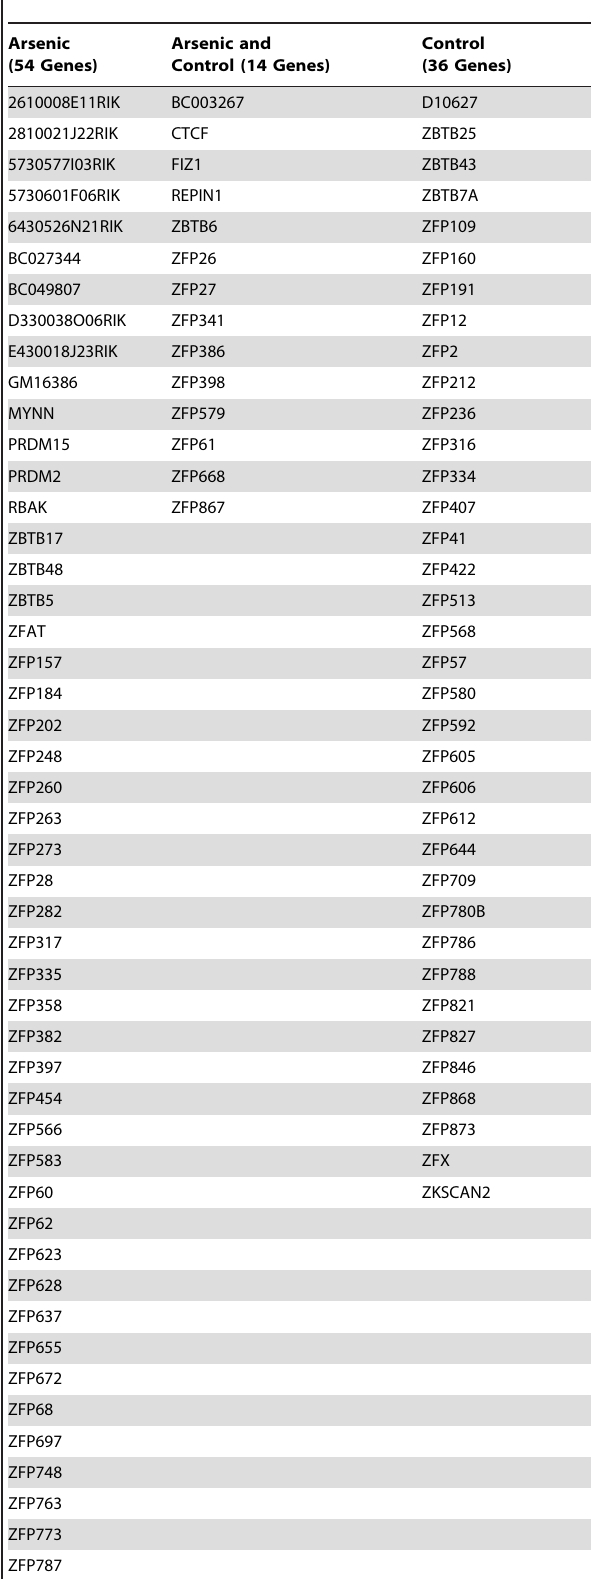
Table 3. List of all unique and overlapping KRAB genes with significant enrichment of H3K9ac identified by HOMER in each of the conditions.